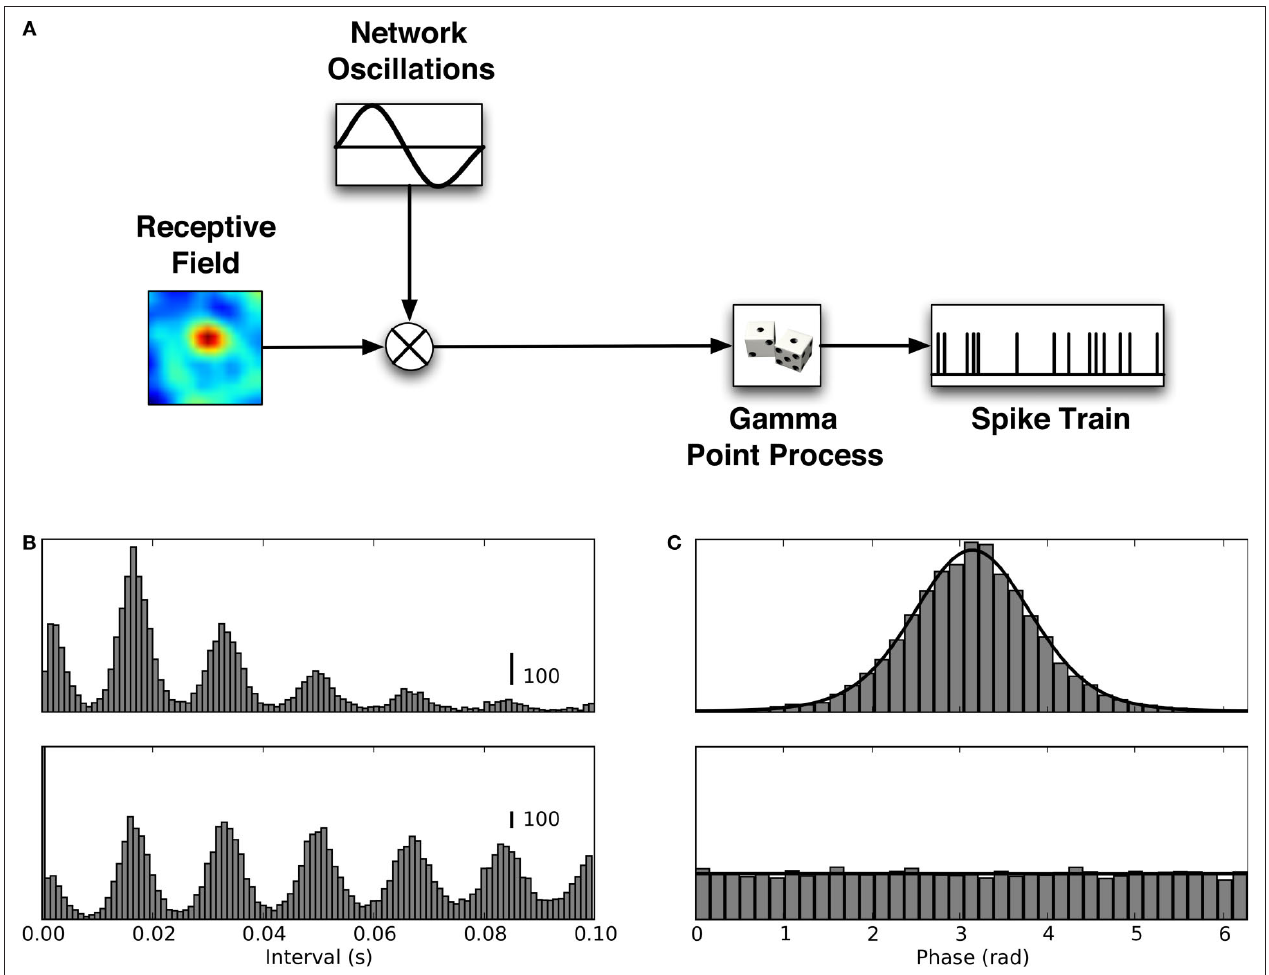
FIGURE 10 | Quasi-periodic gamma (QPG) model reproduces spike timing statistics and phase distributions. (A) QPG model of thalamic neurons that predicts spike statistics and information rate. Spike times are described by an inhomogeneous gamma process; spike rate is the product of two signals, the